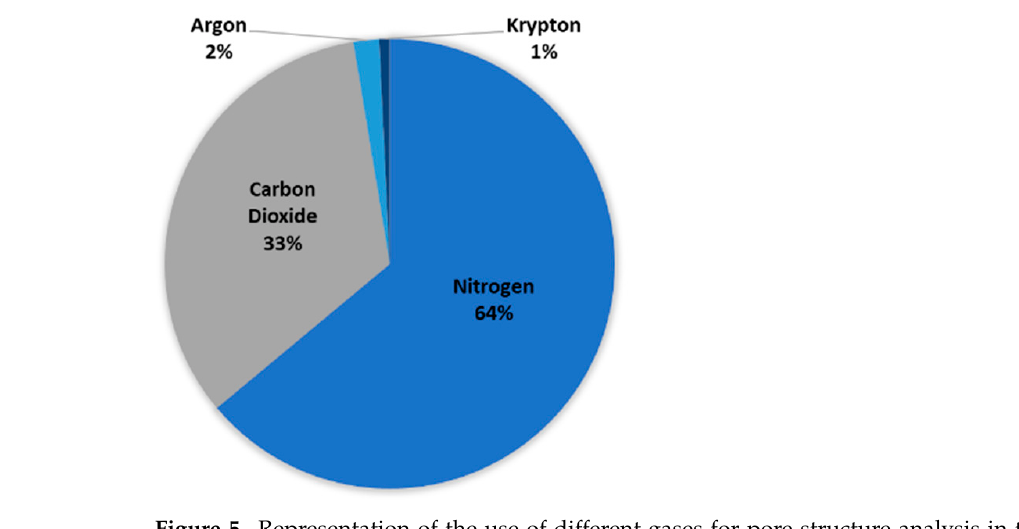
Figure 6. Representation of the main inversion techniques applied for pore structure characteriza ‐ tion on shale systems (Elaborated from analysis of articles in the attached Excel file). In addition, this section aims at providing the most important equations as well as highlighting references to guide the reader in case additional details are required. A table in the Supplementary Materials contains the references, selected for preparation of Fig ‐ ures 5 and 6.